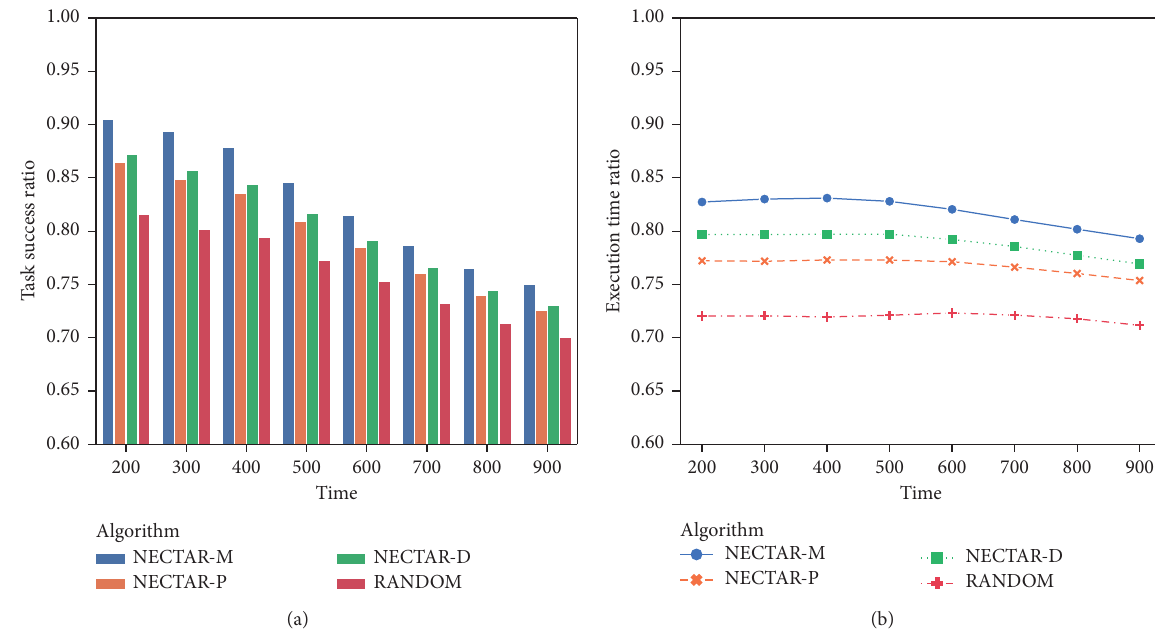
Figure 4: Performance with time